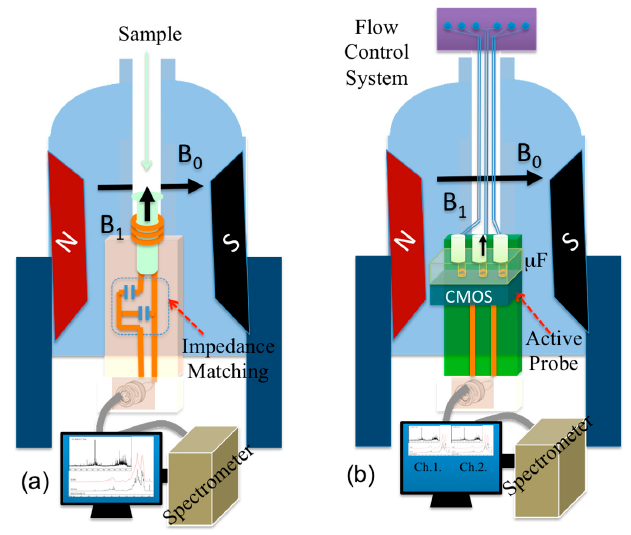
Figure 1. NMR Spectroscopy: Illustrations NMR system with ( a ) passive NMR and ( b ) active probe ( μ F = Microfluidic).